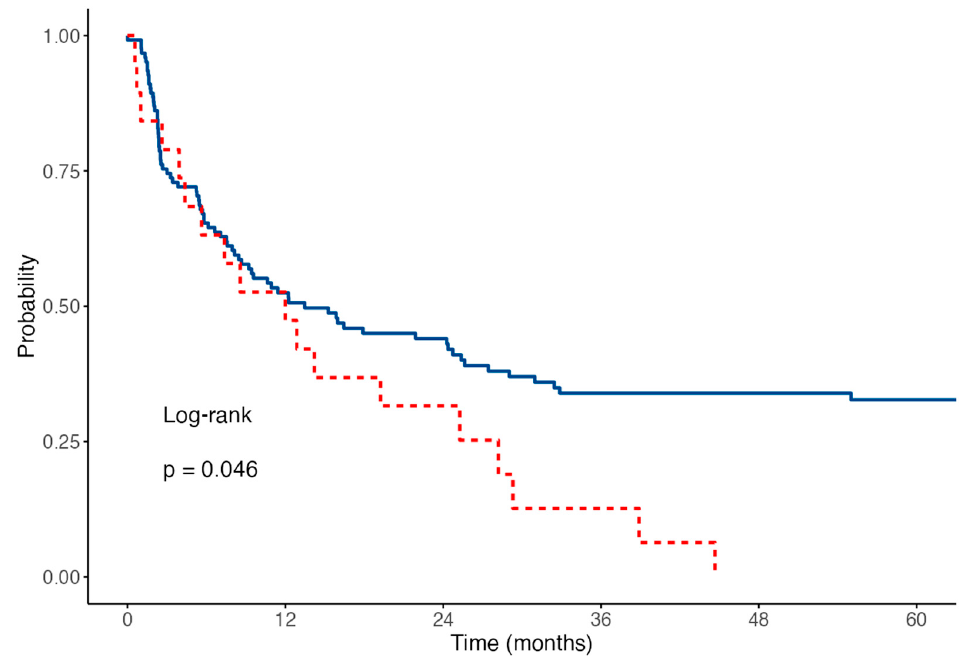
Figure 3. Relapse-free survival, patients with VTE in red, no VTE in blue.